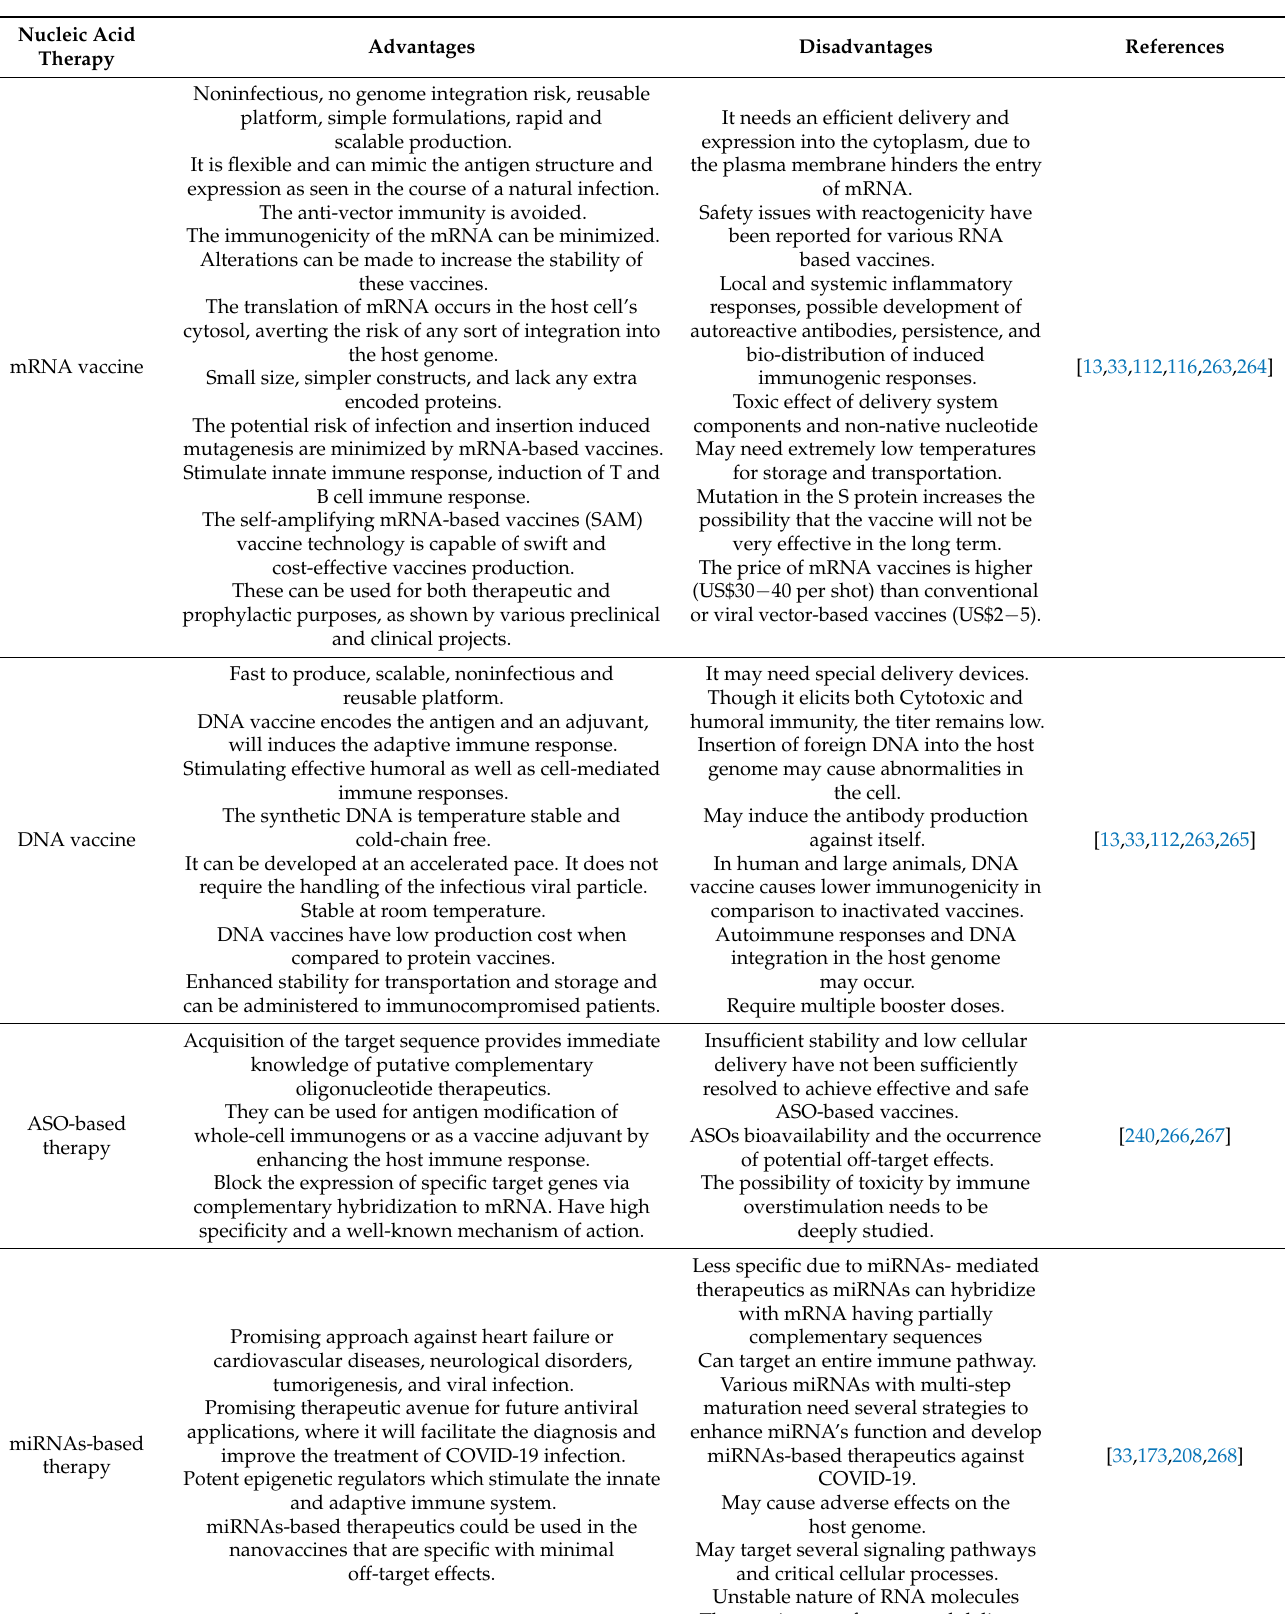
Table 3. Advantages and disadvantages of several